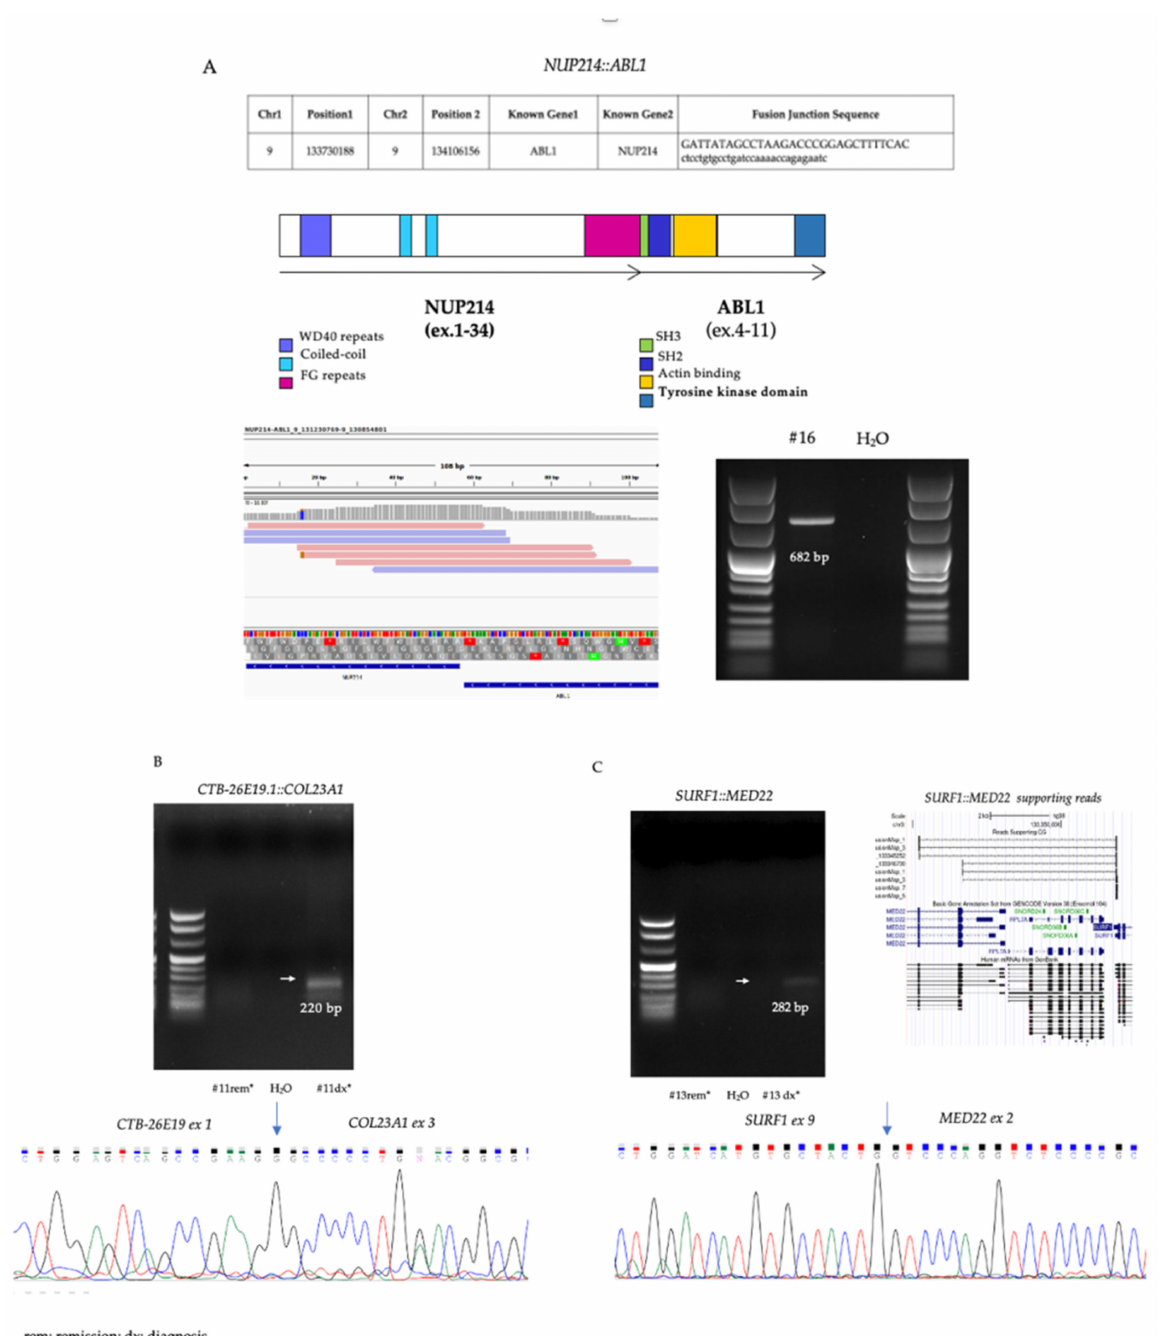
Figure 2. ( A ) RT-PCR validation of NUP214::ABL1 fusion. ( B ) RT-PCR and Sanger sequencing validation of CTB-26E19.1::COL23A1 conjoined gene. ( C ) RT-PCR, Sanger sequencing and supporting reads validation of SURF1::MED22 conjoined